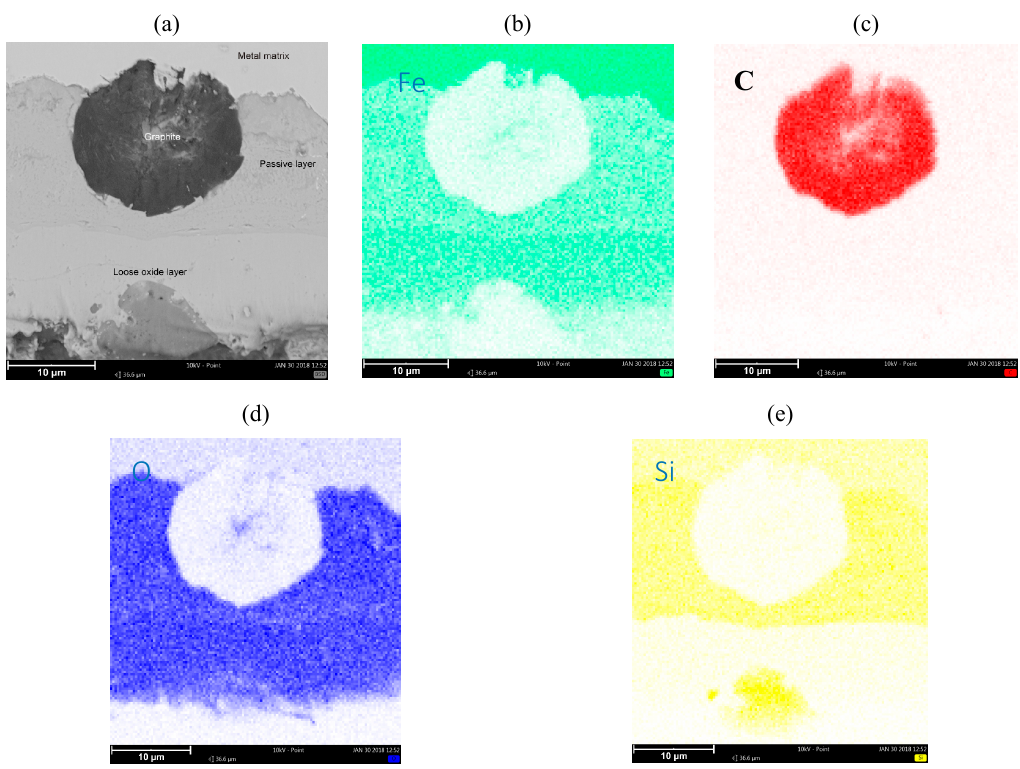
Figure 4. Microstructure of SiMo 3 cast iron, 1.09% Mo ( a ). Map for ( b ) Fe, ( c ) C, ( d ) O, and ( e ) Si. Materials 2020 , 13 , x FOR PEER REVIEW